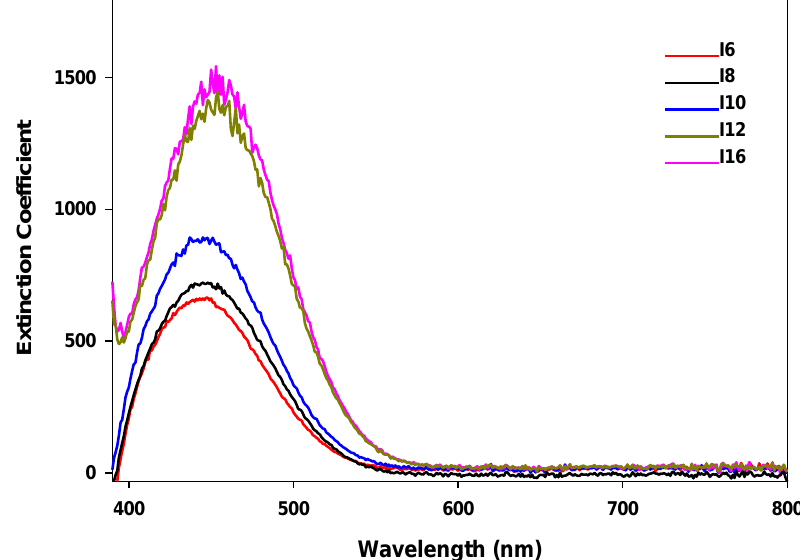
Figure 7. UV-vis spectra of present series, I n , in CH 2 Cl 2 at 25 °C.